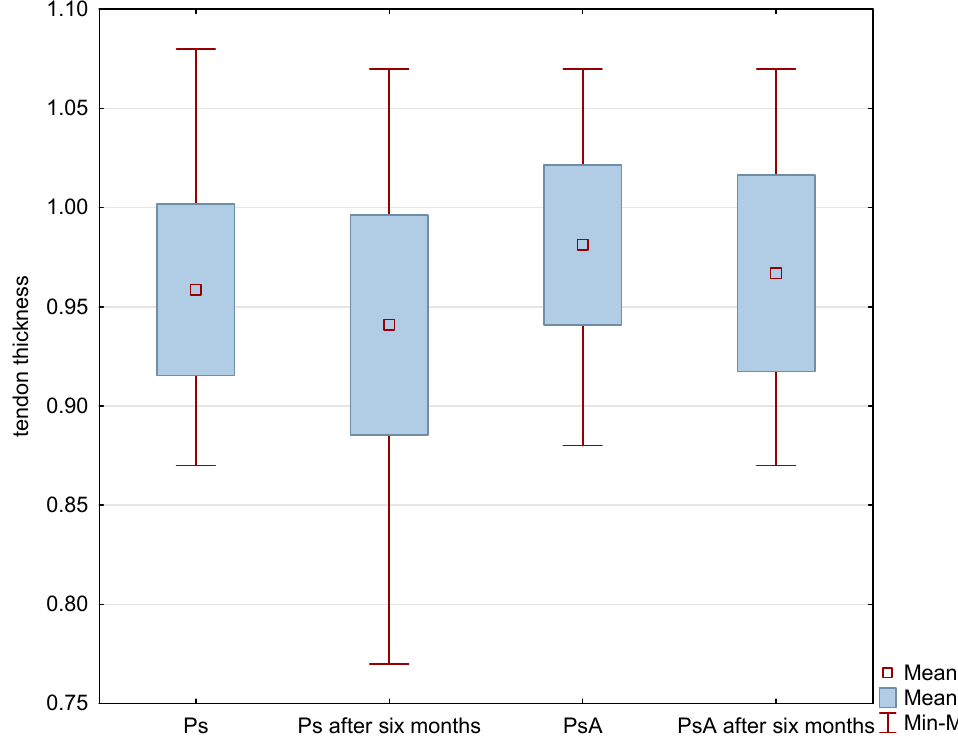
Figure 1. US measurements of tendon thickness in patients studied before and after methotrexate therapy. p < 0.001 Ps before therapy vs. PsA before therapy. p < 0.001 Ps before treatment vs. Ps after six ‐ month therapy. p = 0.61 PsA before therapy vs. PsA after six ‐ month therapy. Ps: psoriasis, PsA: psoriatic arthritis.